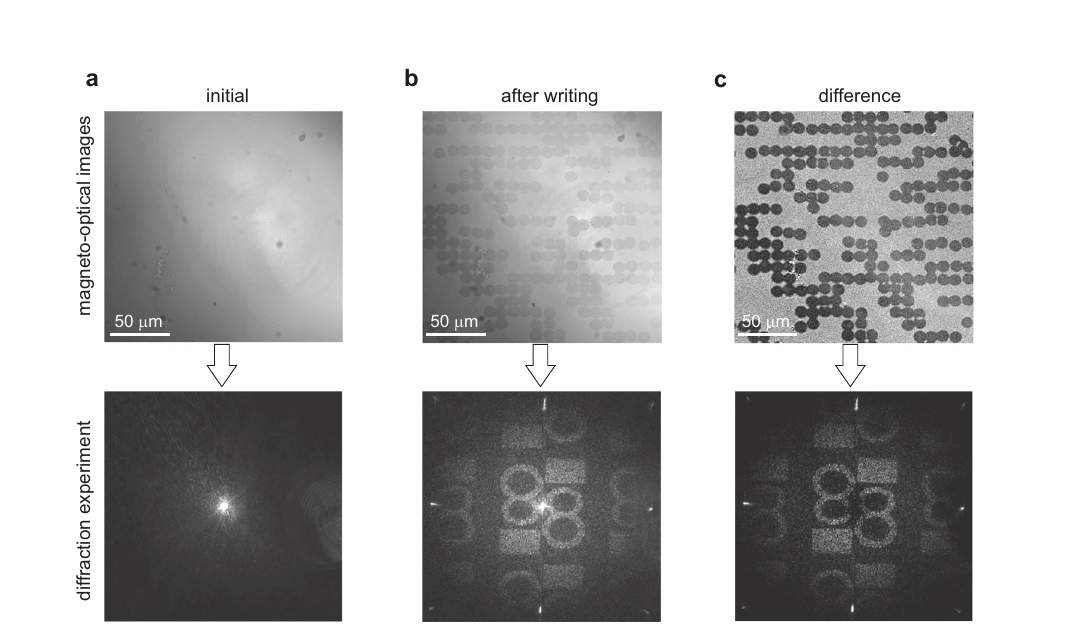
Fig. 5 | Opto-magnetic CGH writing and reading. From left to right shows both the magneto-optical (top panel) and diffraction (bottom panel) images in the GdFeCo sample a before the opto-magnetic writing, b after writing, and c the